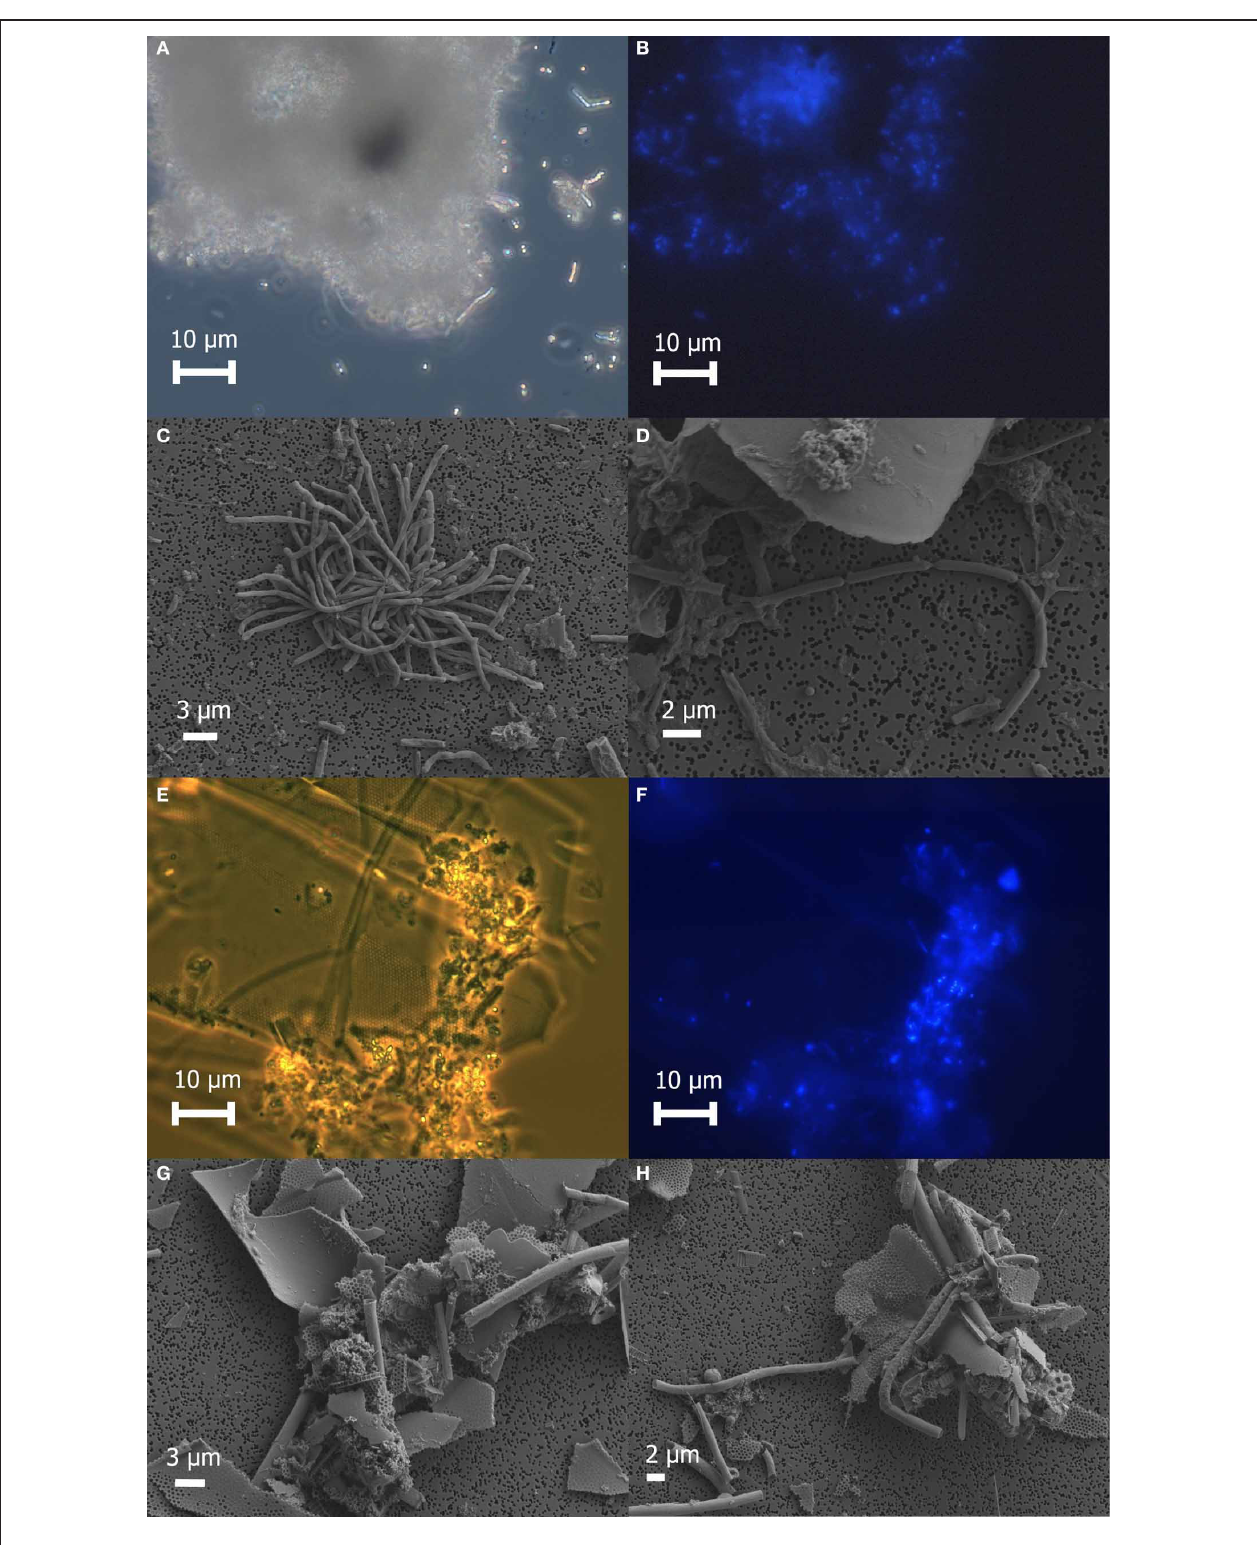
FIGURE 2 | Microscopic examination of white floc 2 (panels A through D) and orange floc (panels E through H). Paired phase contrast (A) and epiflourescent (B) images of DAPI-stained cells in white flocculent material from the Subway snowblower vent. SEM images of white floc show